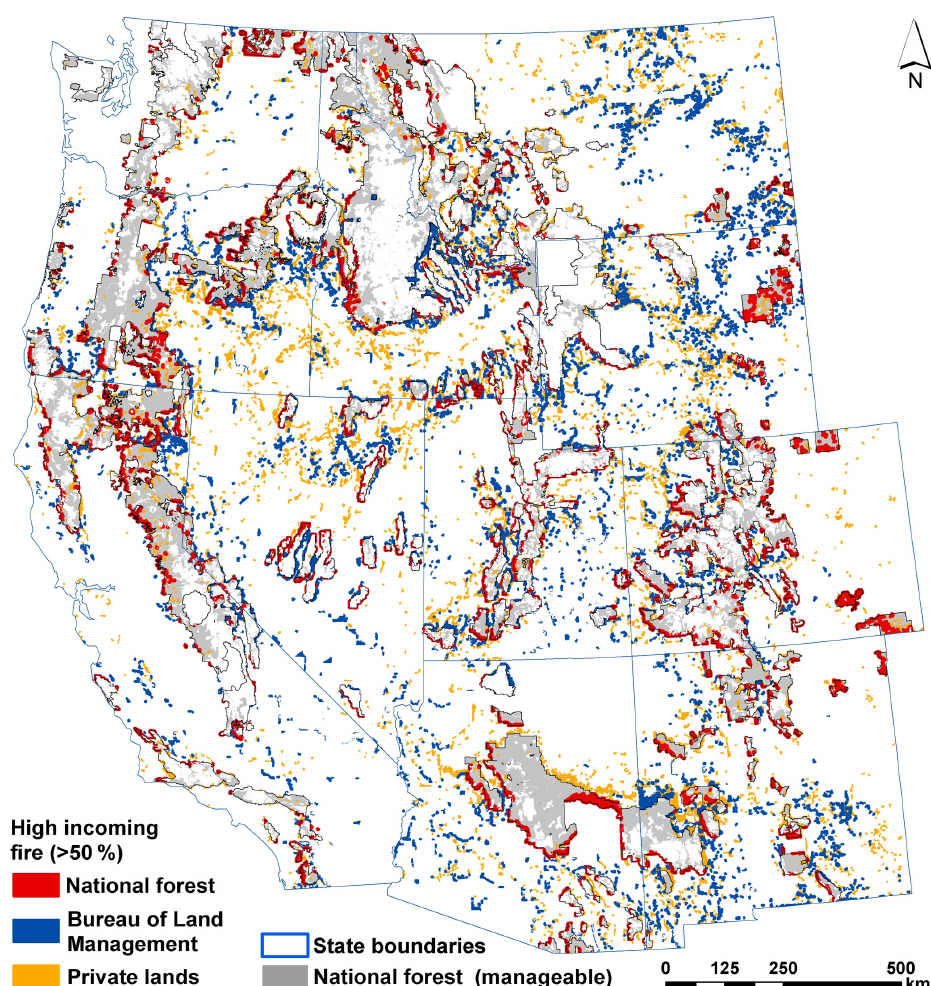
Figure 5. Locations where incoming fire exceeds > 50% of the total fire (incoming + self-burning) on the three larger land tenures of the western US.